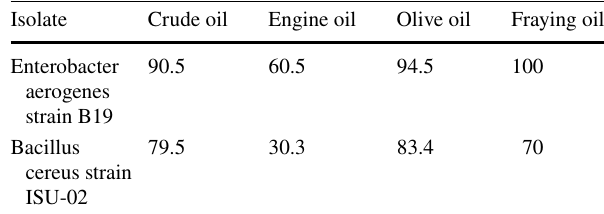
Table 7 Emulsification index E24%